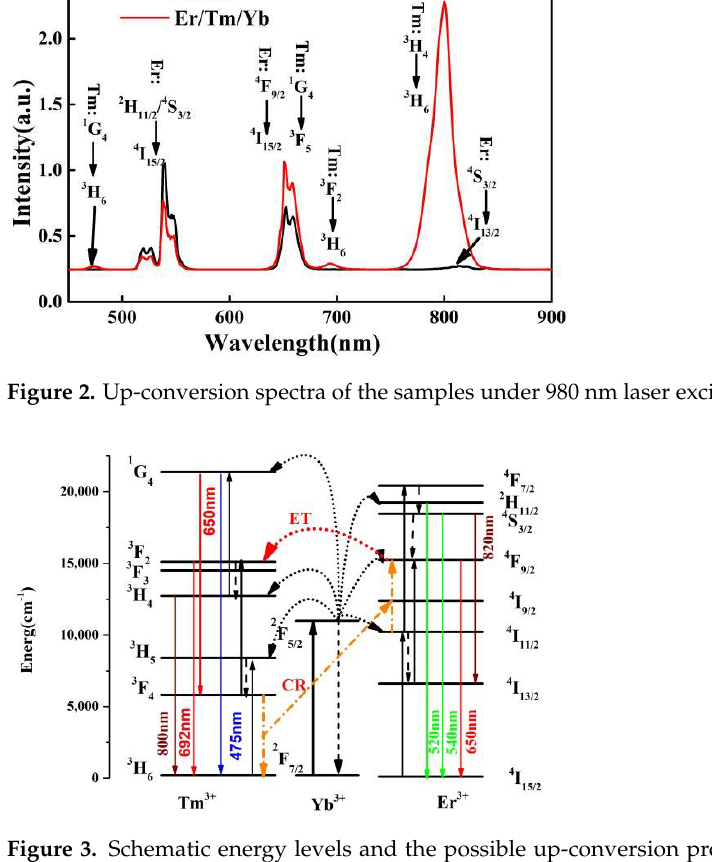
Figure 3. Schematic energy levels and the possible up-conversion processes in Er 3+ , Tm 3+ , Yb 3+ co-doped materials.